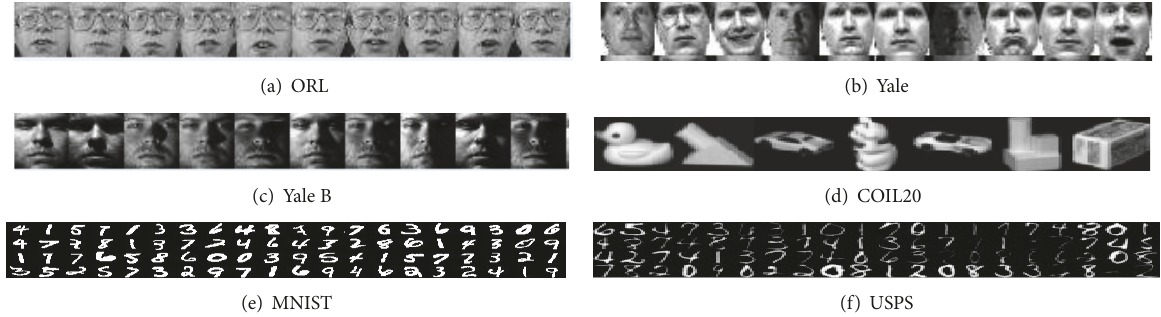
Figure 1: Different image datasets: (a) ORL, (b) Yale, (c) Yale B, (d) COIL20, (e) MNIST, and (f)